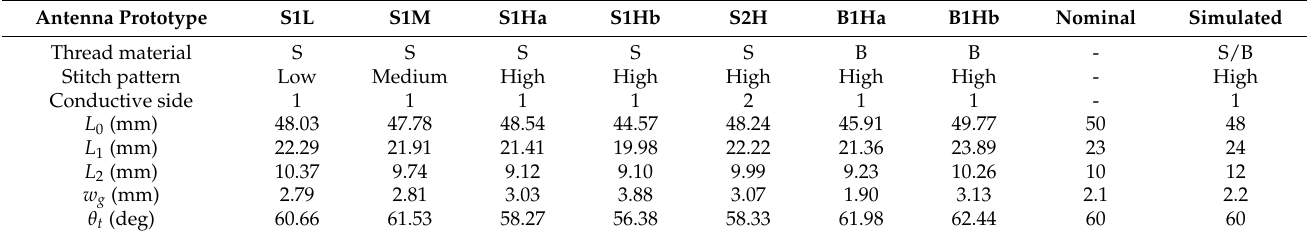
Table 1. Geometrical and fabrication characteristics of the antenna prototypes.